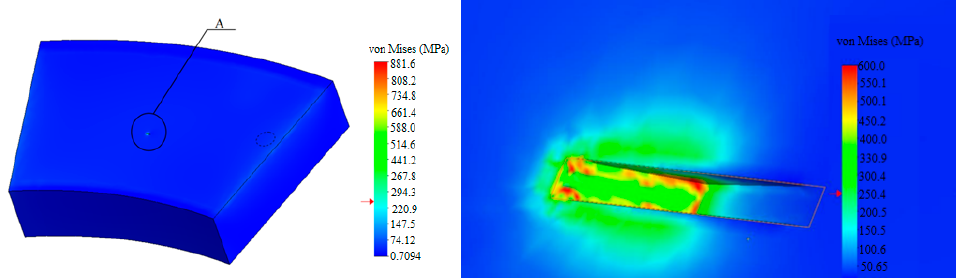
Figure 8. The stress field in the part of the thrust bearing disc and defect No. 1.